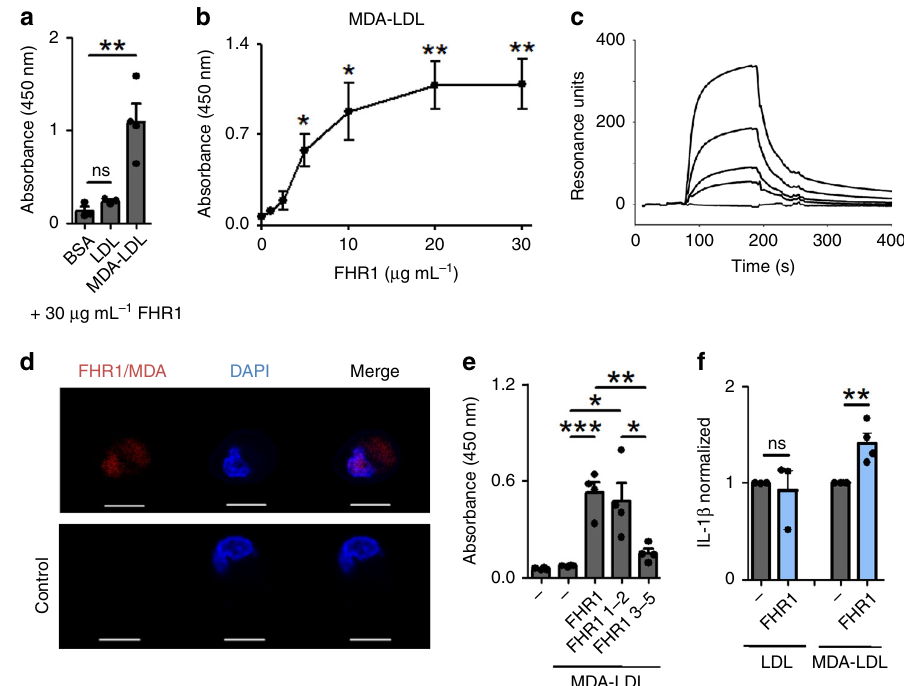
Fig. 6 FHR1 binds to MDA-LDL on necrotic cells. a FHR1 binds to MDA-LDL, but not to LDL or BSA. b FHR1 binds to MDA-LDL in a dose-dependent manner as shown by ELISA and c surface plasmon resonance. d FHR1 binds to MDA epitopes on necrotic cells, as demonstrated by proximity ligation assay. Red dots denote FHR1-MDA complexes. DNA is stained with DAPI (blue). Control = one antibody. e FHR1 binds with its N-terminus FHR1 SCR1-2 to MDA-LDL. f FHR1 bound to MDA-LDL, but not LDL, increases IL-1 β release by monocytes. Data in a – f represent the mean ± SEM. of three to four independent experiments with different cell donors. * p ≤ 0.05, ** p ≤ 0.01, *** p ≤ 0.001 (unpaired two-tailed t